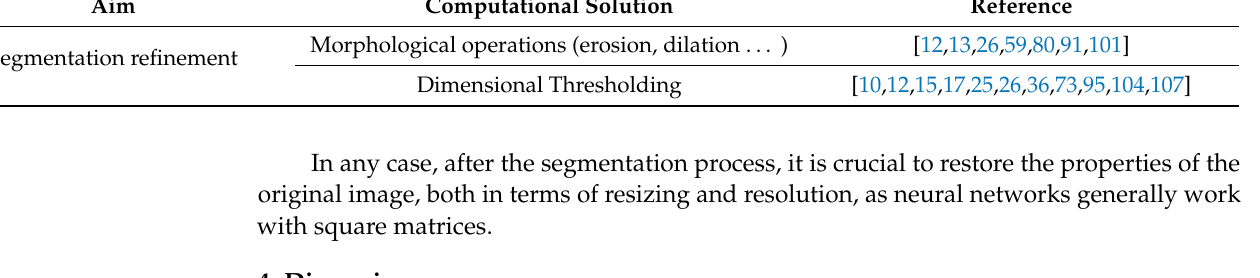
Table 7. The most common post-processing operations. Aim Computational Solution Reference Morphological operations (erosion, dilation . . . Segmentation refinement